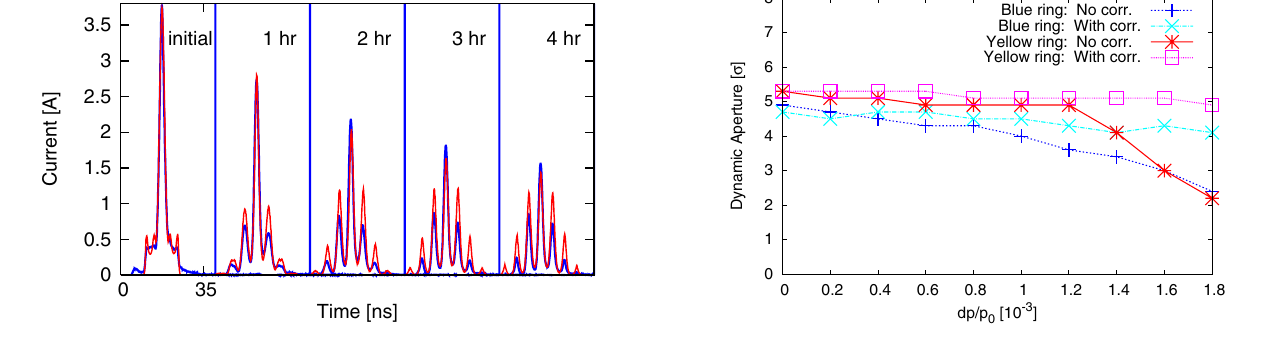
FIG. 7. Calculated off-momentum dynamic apertures for the IBS-suppression lattices without and with second order chroma- ticity